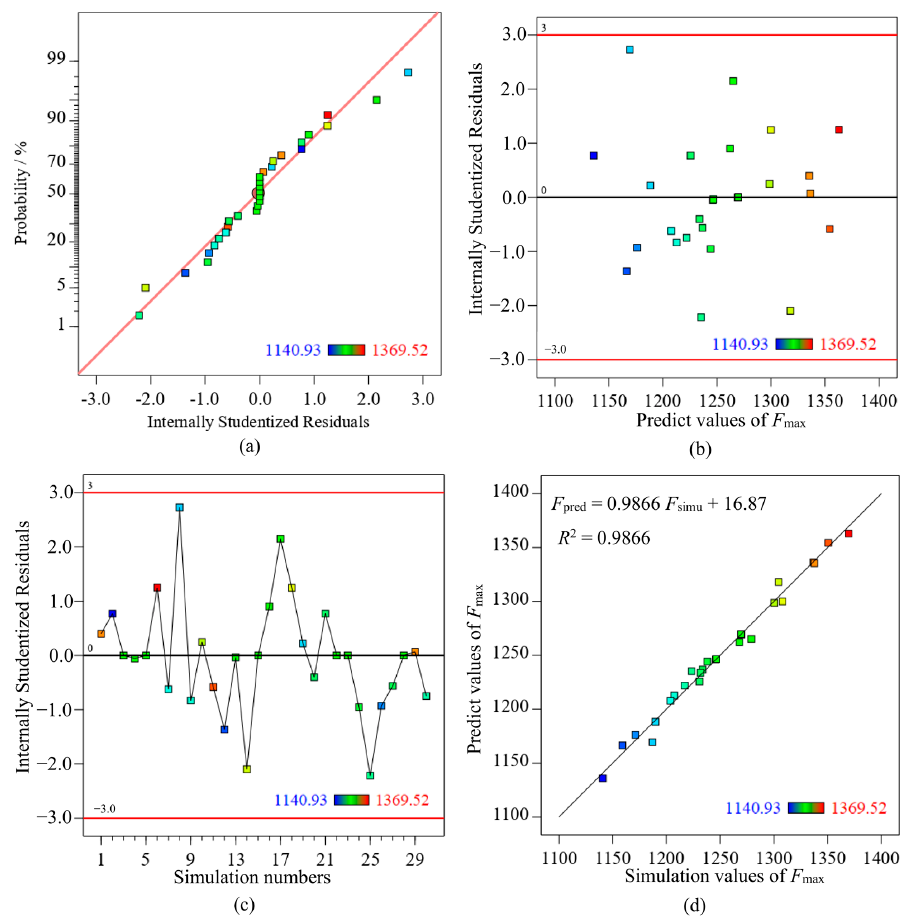
Figure 8. Rationality of the relational expression of partial factors using residuals analysis: ( a ) normal probability plot of residuals, ( b ) residuals versus predicted values, ( c ) residuals versus simulation numbers and ( d ) predicted and simulated values of F max . (Color points by value of shearing strength).